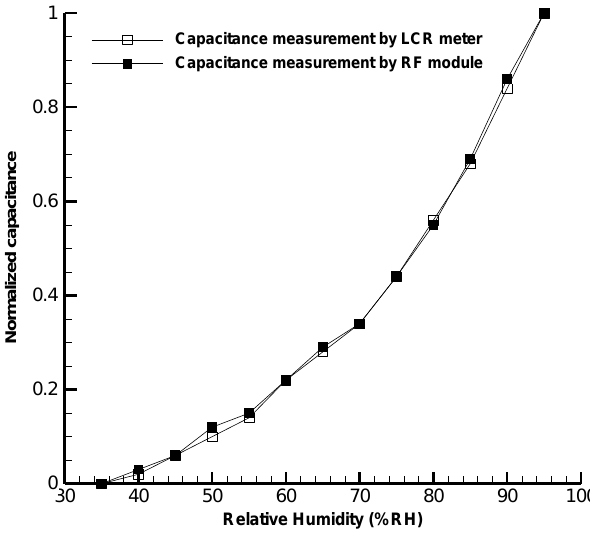
Figure 7. Comparison between capacitance measurement by LCR meter and by RF module at the temperature of 25 °C.